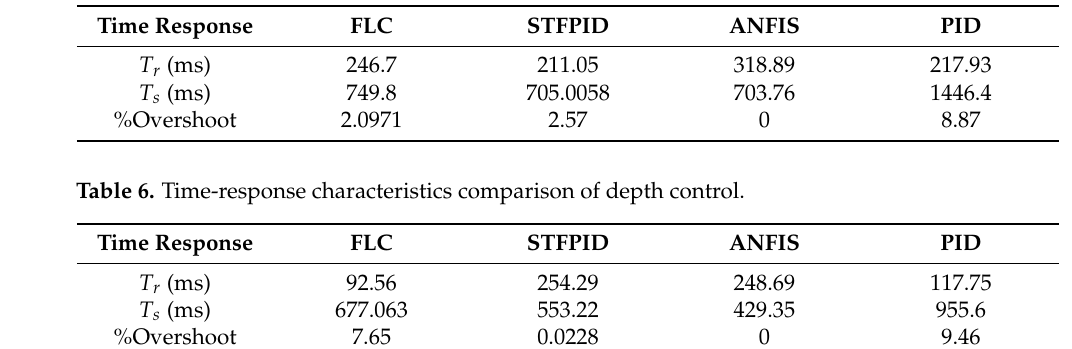
Table 5. Time-response characteristics comparison of heading plane control.